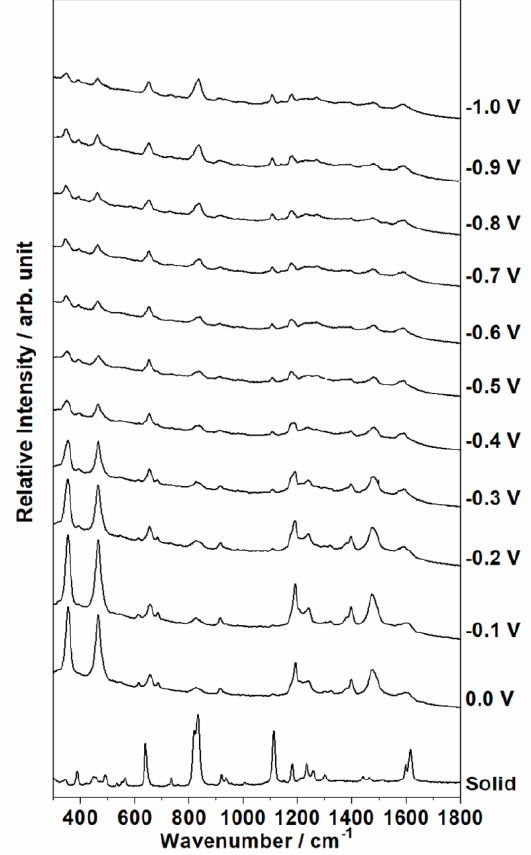
Figure 2. Electrochemical SERS spectra of sonicated BPA/Na 2 SO 4 (1 mM/0.1 M) aqueous solution at different electrode potentials using the 785 nm exciting line. Raman spectrum of solid at the bot- tom.